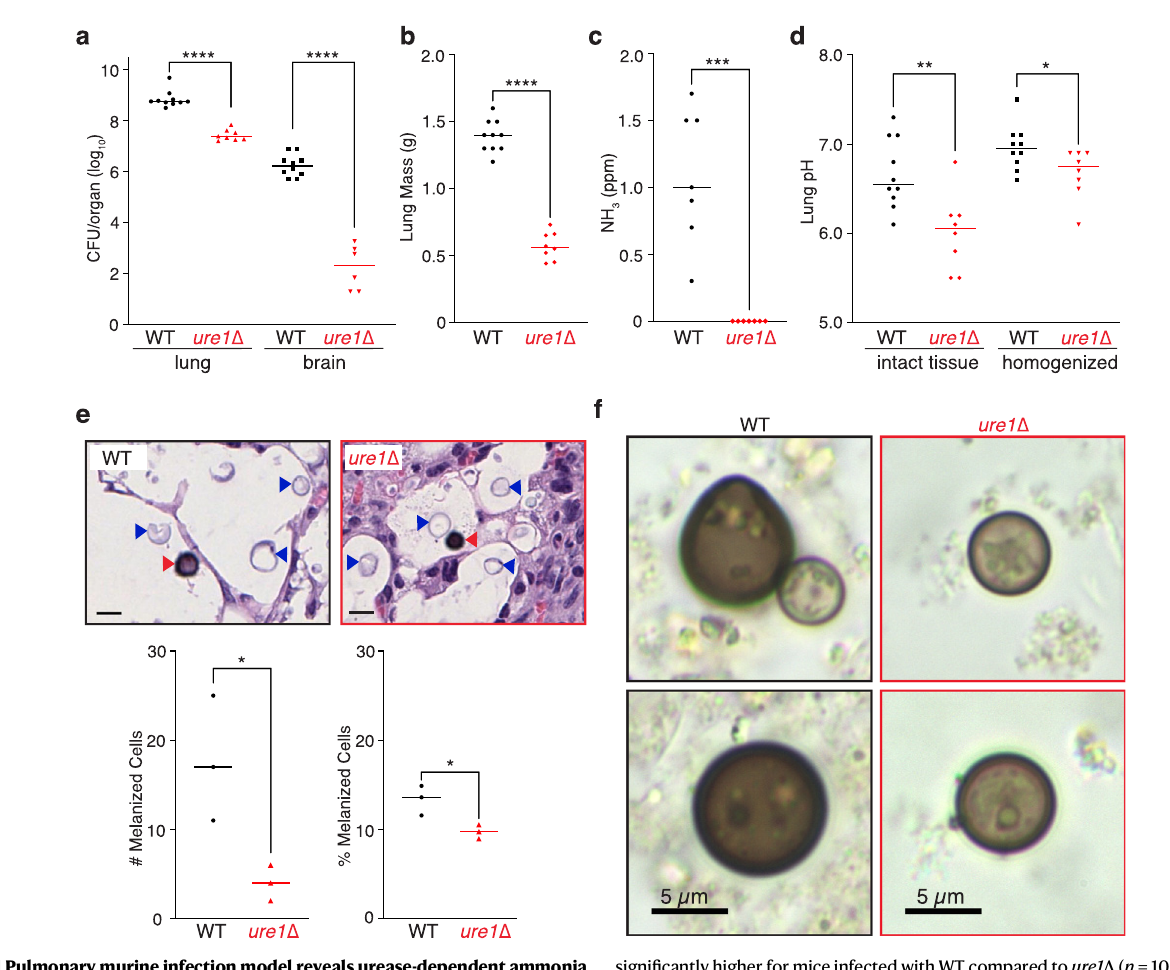
signi fi cantlyhigherformiceinfectedwithWTcomparedto ure1 Δ ( n =10,WT; n =8, ure1 Δ , ** p =0.0036 and * p =0.0358, respectively). e Representative images (upper panels) of H & E stained lung tissue sections from three mice infected with either WT or ure1 Δ (blue arrows; scale bars=10 µ m). Quanti fi cation of the total number (lower left panel; n =3, * p =0.0316; unpaired, two-sided parametric t -test) and percentage (lower right panel; n =3, * p =0.0274;unpaired, two-sided parametric t - test) of heavily melanized cryptococcal cells (red arrows) detected in tissue sec- tions from three infected animals. f Representative bright fi eld images from three independentpreparationsofmelanin-richparticlesisolatedfromthelungsofmice infected with either WT or ure1 Δ cells after boiling homogenized tissue in con- centrated hydrochloric acid. Source data are provided as a Source Data fi